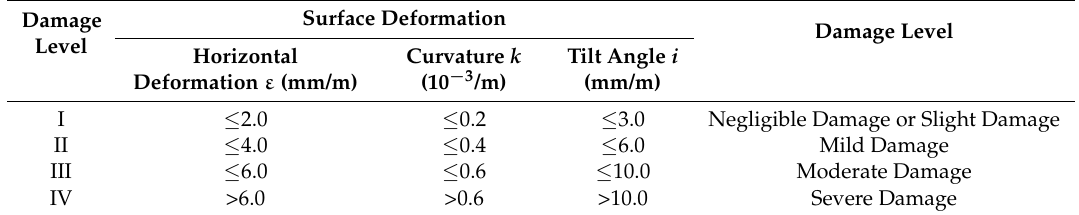
Table 12. China Coal Association’s brick–concrete structure damage grade system.